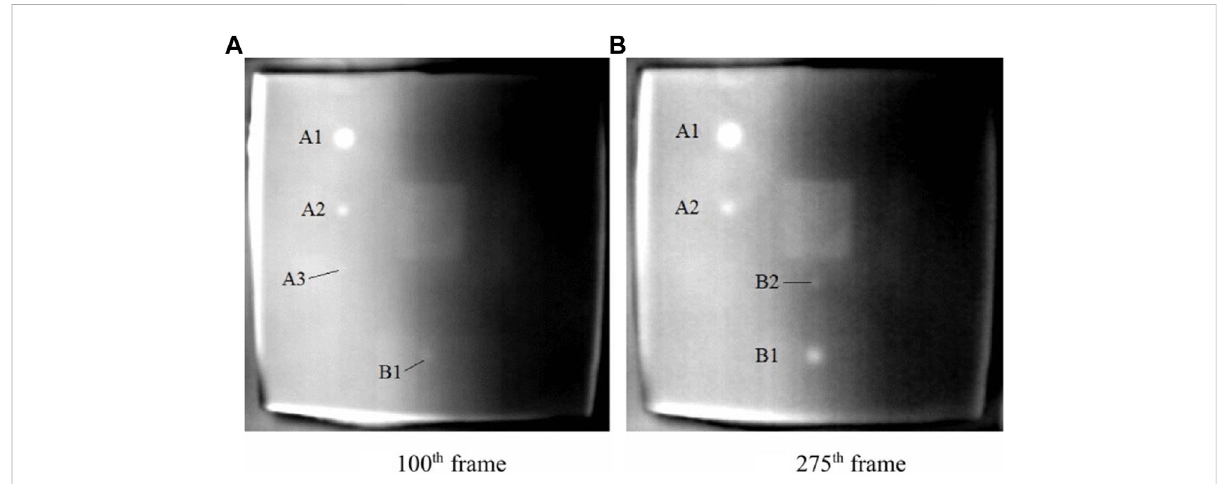
FIGURE 2 Raw thermal images ofsiliconrubber plate specimen (A) The 100th frame ofraw thermal images sequence, (B) The 275thframe of rawthermal images sequence (Liu et al.,